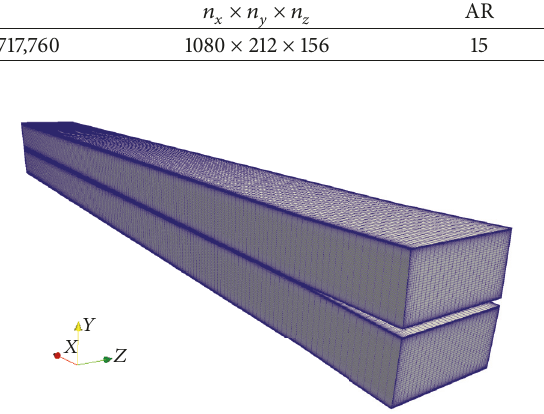
Figure 2: Computational domain with the mesh B used for the RANS calculations.